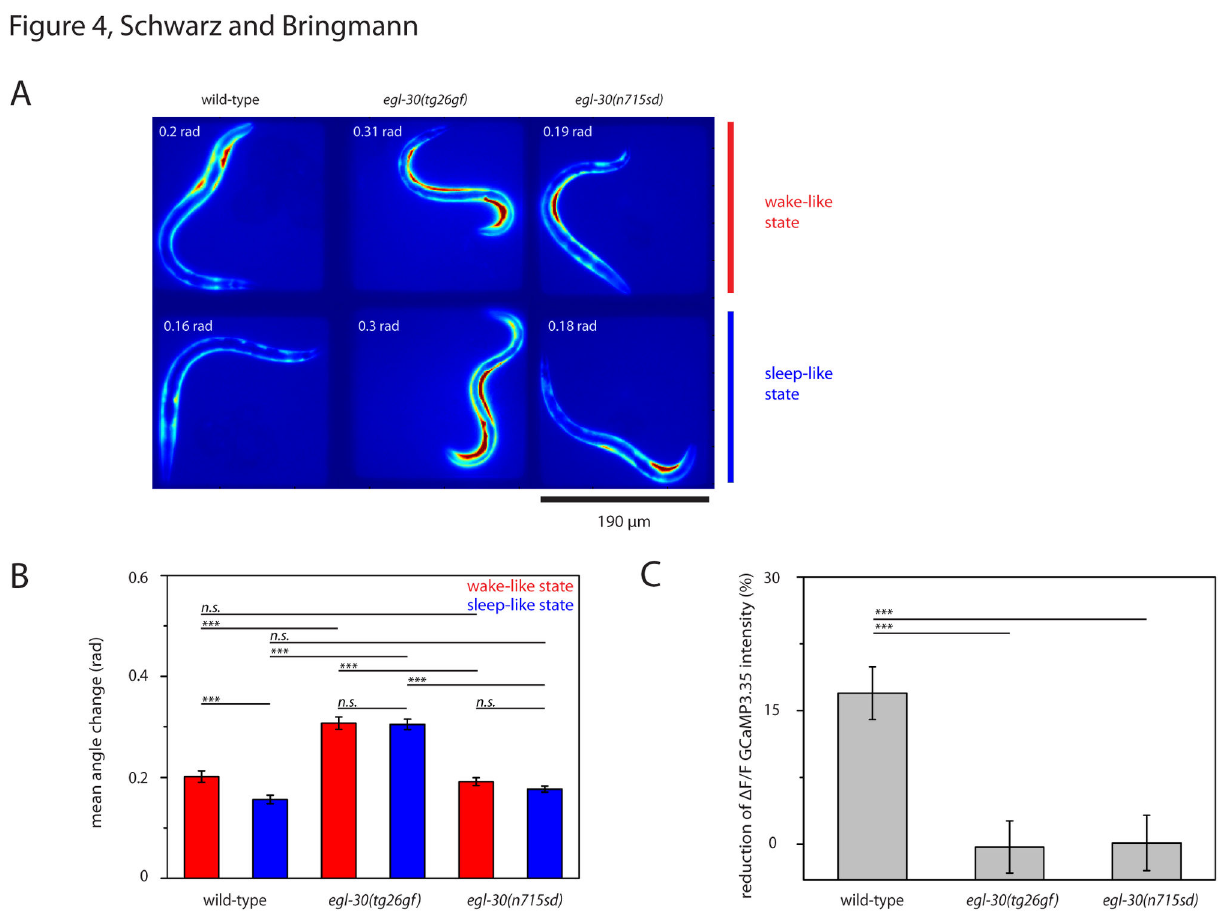
Figure 4. Reduced muscle relaxation in egl-30 mutants during sleep-like behavior. A False color fluorescence images of wild type and egl-30 mutants expressing GCaMP3.35 in body wall muscle during the wake-like state (top) and during the sleep-like state (bottom). Bright signals reflect muscle activity. The angle change is displayed for each example worm. B Mean angle change in wild type and egl-30 mutants during wake-like and sleep-like state. C Reduction of muscle calcium signals in wild type and egl-30 mutants. Note the reduction of angle change and muscle calcium during sleep-like behavior in wild type. Body curvature and muscle calcium are much less reduced in egl-30 mutants. Error bars represent SEM. For each strain ≥ 10 animals were tested (two-sample t-test for comparisons between different genotypes, paired sample Wilcoxon test for comparison of wake-like and sleep-like behavior, *** denotes statistical significance at